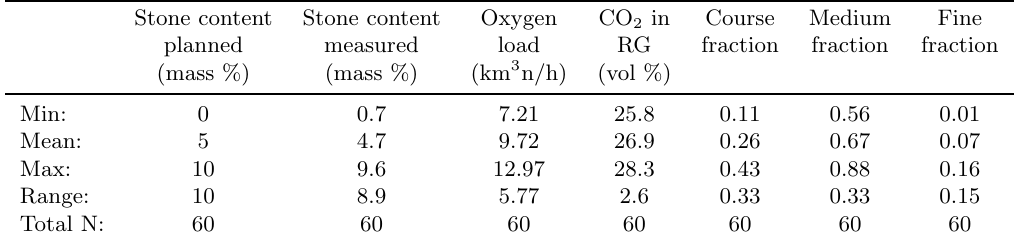
Table 2: Process variables and summary